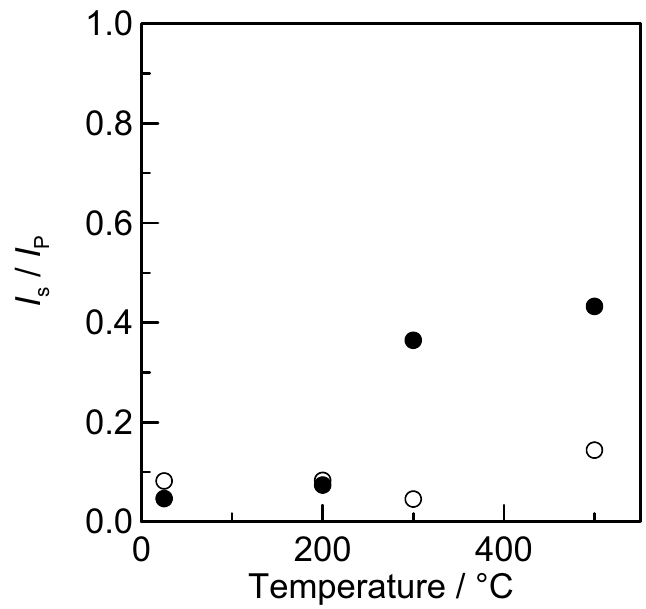
Figure 7. Plot showing the correlation between I S / I P and the calcination temperature. Here, the intensity I S of the diffraction peak near 38° is for metallic silver, and the intensity I P of the diffraction peak near 33° is for silver orthophosphate. Open circles indicate data for raw silver phosphate, and closed circles indicate data for the paste (mixture with CMC-Na).